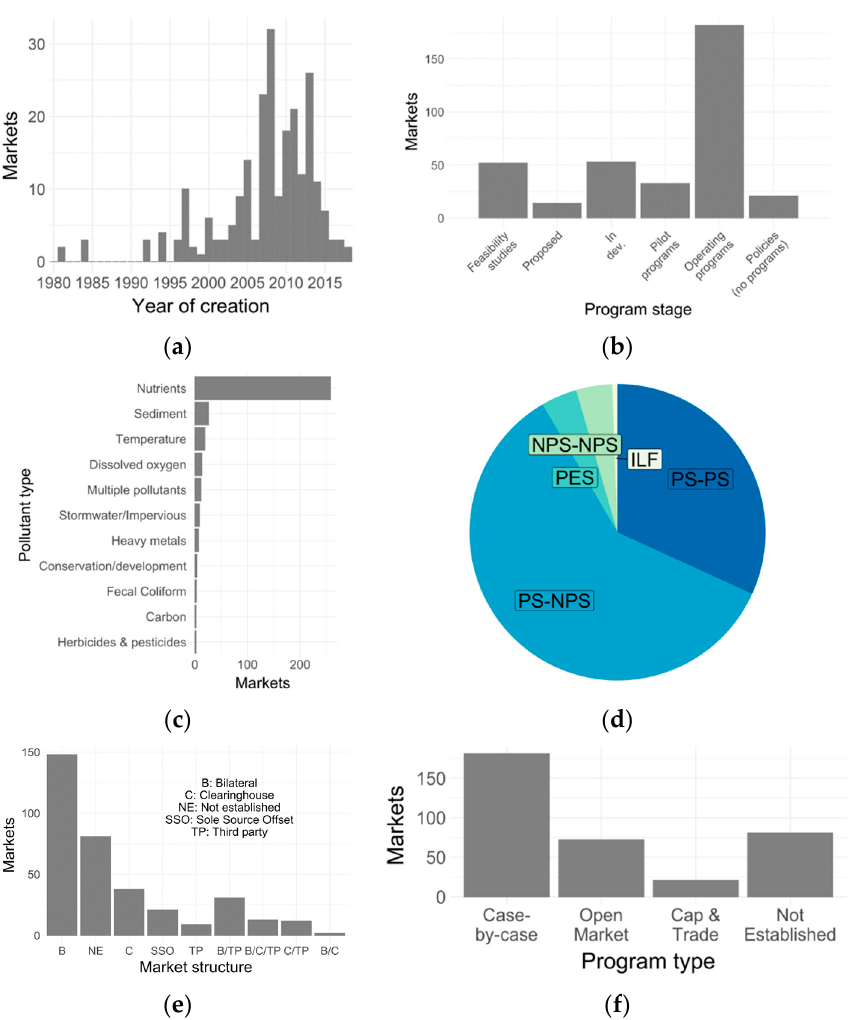
Figure 2. Water quality trading (WQT) programs, by ( a ) year created, ( b ) program stages, ( c ) pollutants traded, ( d ) trans- action types, ( e ) market structures, and ( f ) program